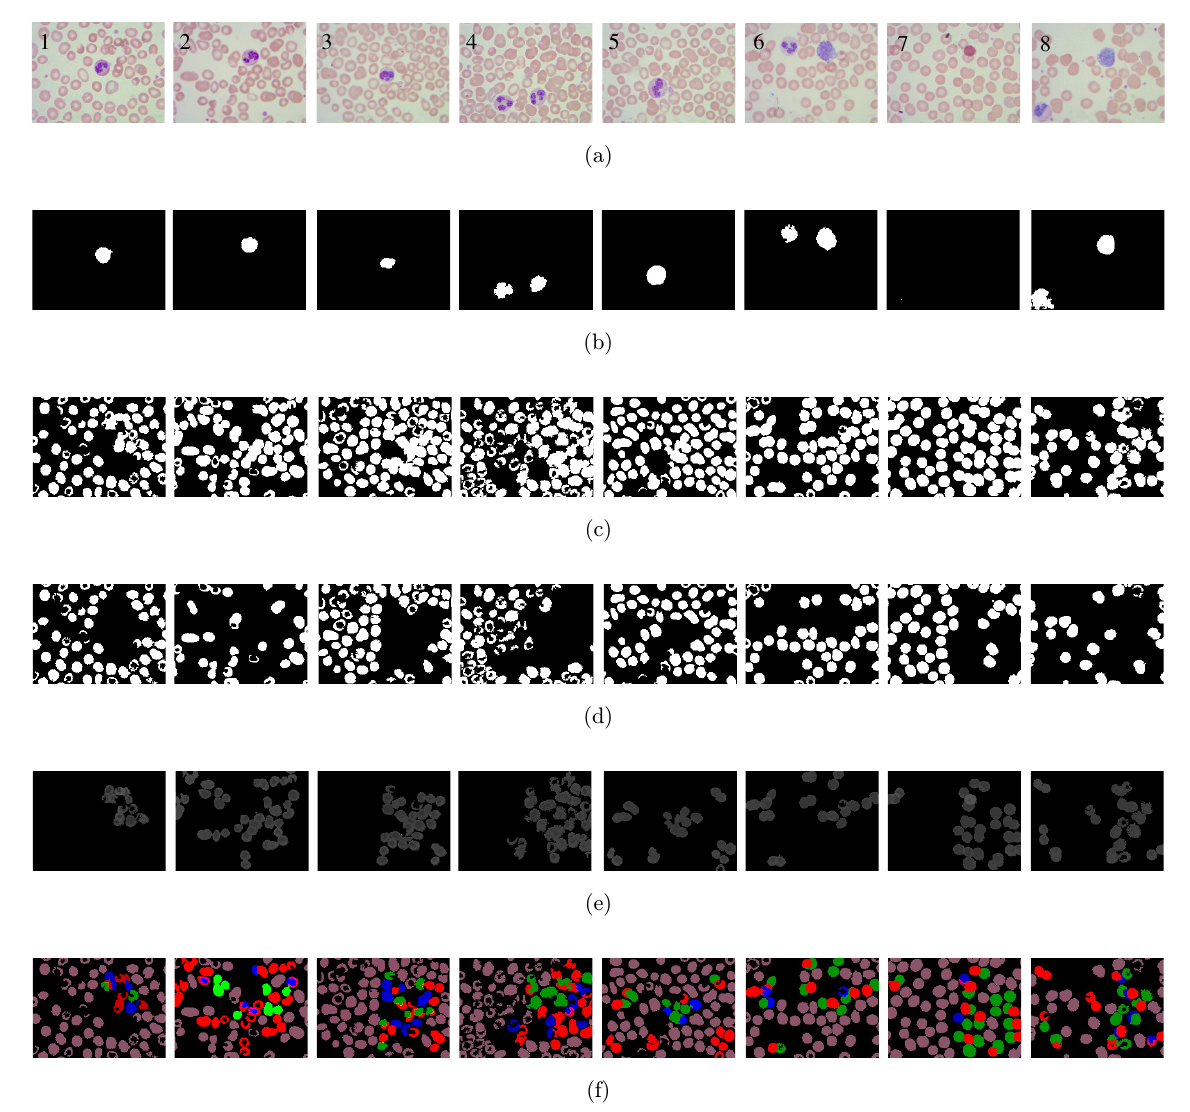
Fig. 7. Representative experimental results. (a) original microscopic smear blood images, (b) detection of WBC, (c) erythrocytes only, (d) classi¯cation of individual ones, (e) clustering with K-means of overlapping ones and (f) di®erent classes of erythrocytes.